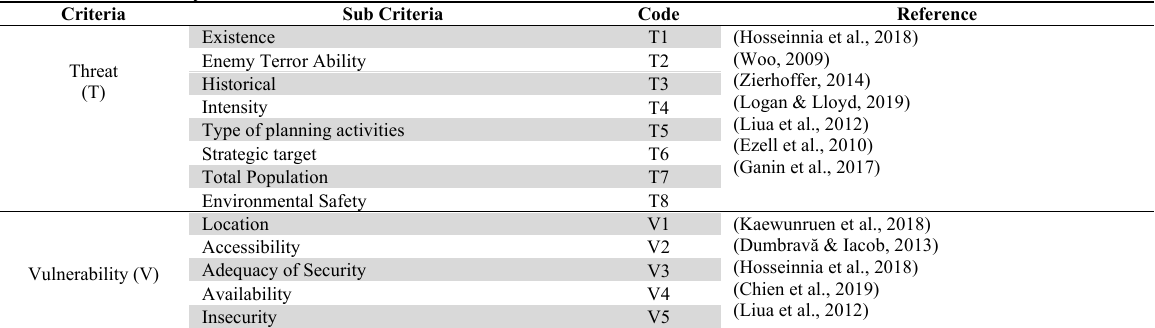
Terrorism Risk Analysis Criteria and Sub Criteria